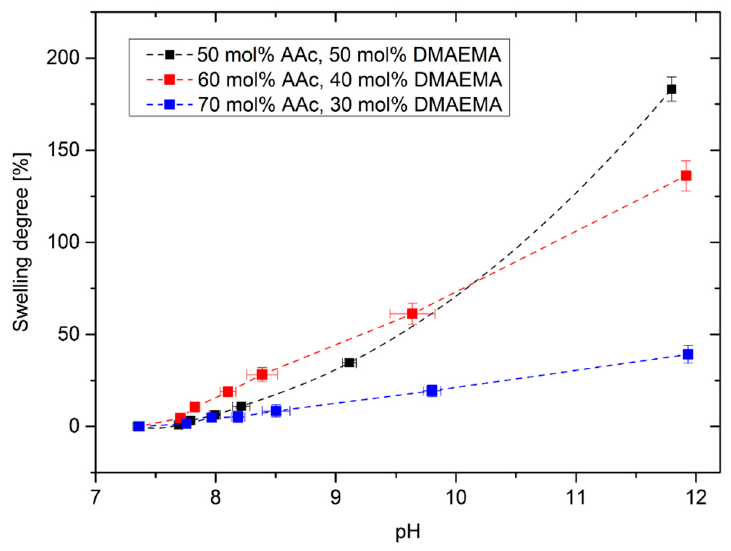
Figure 3. Swelling degree of poly(AAc ‐ co ‐ DMAEMA) hydrogels versus pH value for different monomer contents in PBS buffer.